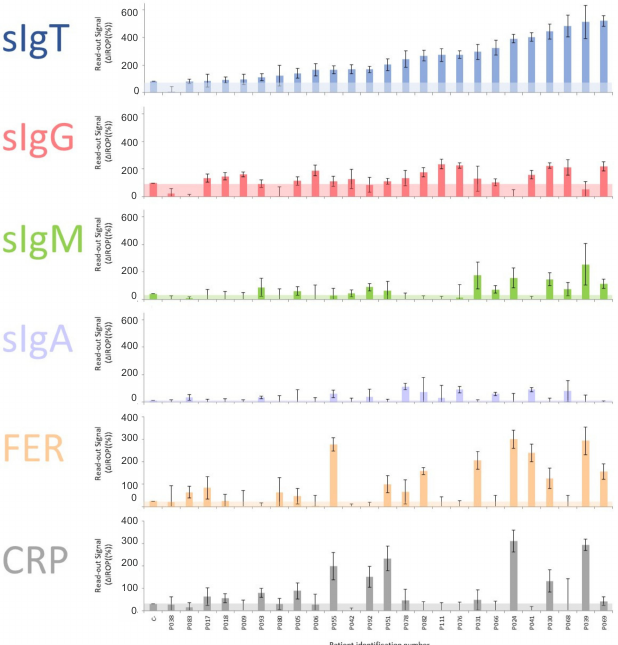
Figure 3. Results of the biomarkers measured in samples from patients with Severe symptoms. The cut-off for each marker is shown in colored shading. Abbreviations: total specific Immunoglobulins (sIgT), specific Immunoglobulins G (sIgG), specific Immunoglobulins M (sIgM), specific Immunoglob- ulins A (sIgA), together with Ferritin (FER), Reactive Protein (CRP) and ∆ IROP (%) (Increased Relative Optical Power.